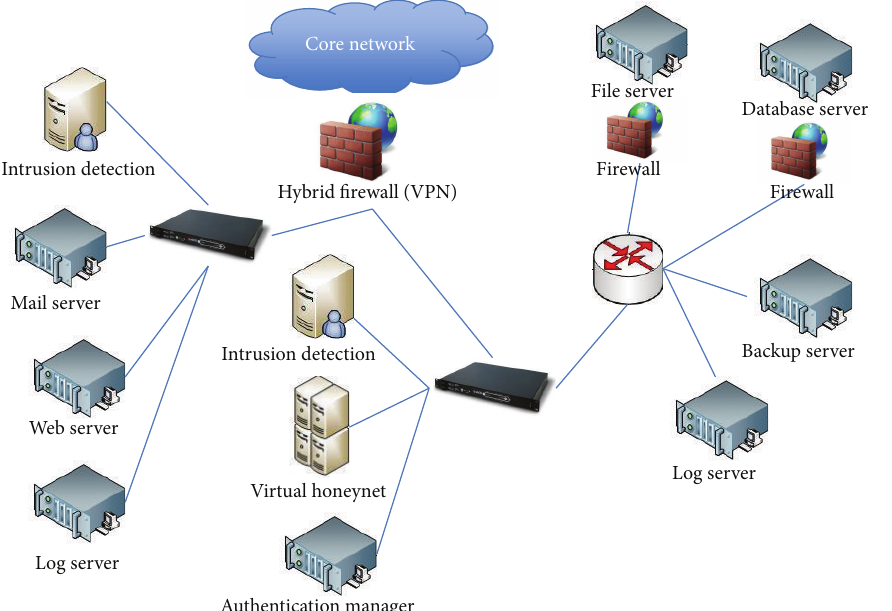
Figure 1: Network defense